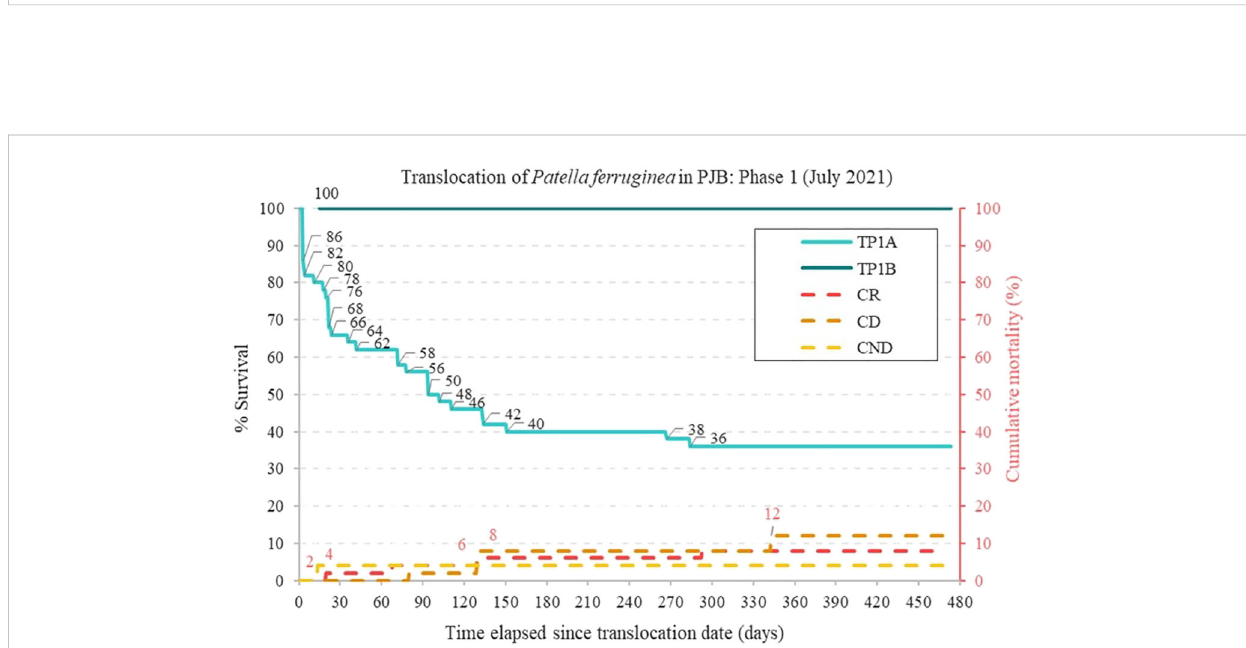
FIGURE 8 Translocations P1A and P1B with control areas in Puerto Jose ́ Banu ́ s. Change in survival (%) of limpets in the translocation experiments in TP1A (Translocation P1A) and TP1B (Translocation P1B) and cumulative mortality (%) in the secondary axis of the control areas (CR, receptor control; CD, donor control; CND, non-donor control) from 15 July 2021 to 31 October 2022 (16 months). Number of limpets surveyed: NTP1A = 50; NTP1B = 3; NCR = 50; NCD = 50; NCND = 50.